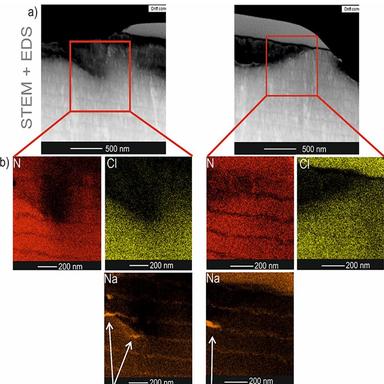
Qualitative chemical analysis of the Zr/Zr2N (1:4 ratio) multilayer coating conducted in the anodic dissolution region by EDS; a) STEM images marked with the regions of analysis; b). maps of selected element distribution.